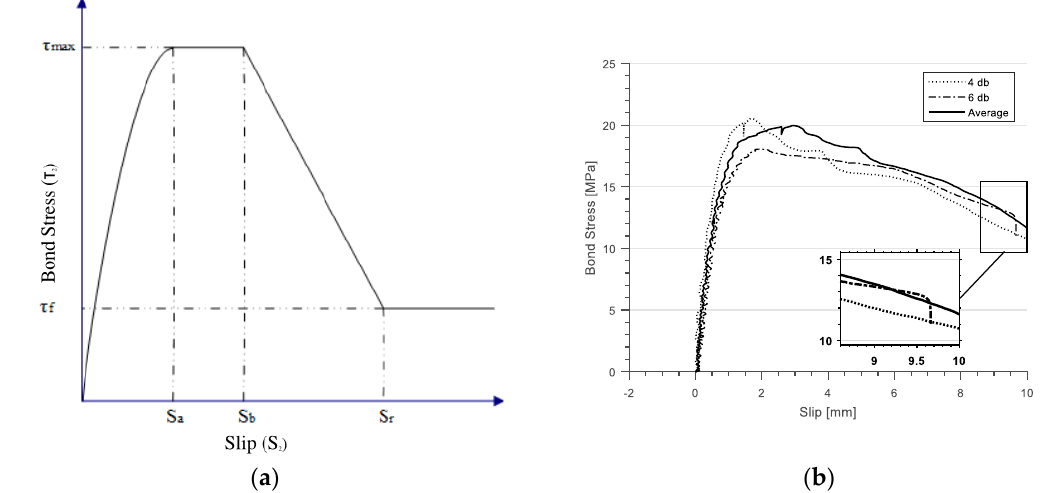
Figure 3. ( a ) Bertero, Popov, and Eligehausen (BPE) bond–slip law (recreated after Eligehausen et al. [18]); ( b ) experimental results.